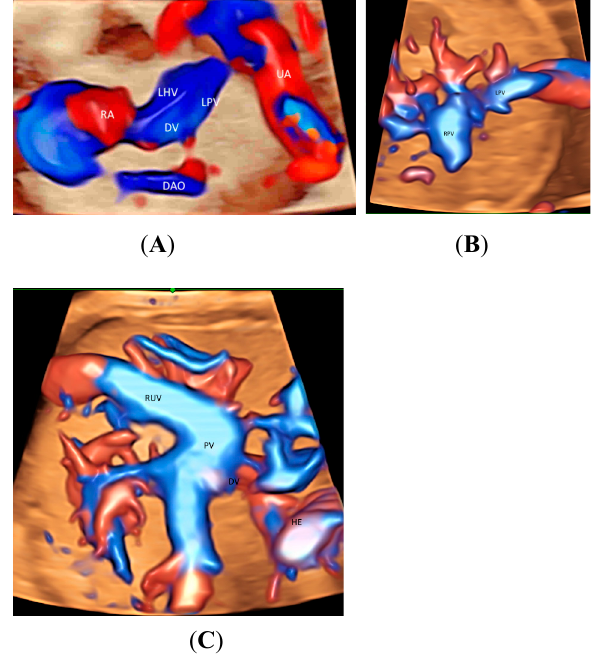
Figure 4. Spatiotemporal image correlation volume acquisition in color Doppler displayed in glass- body mode in a longitudinal view of a normal fetus at 14 weeks’ gestation ( A ), in a transverse view of a normal fetus at 21 weeks ( B ), and of a fetus with persistent right umbilical vein at 29 weeks ( C ). DAO, descending aorta; DV, ductus venosus; HE, heart; LHV, left hepatic vein; LPV, left portal vein; PV, portal vein; RA, right atrium; RPV, right portal vein; RUV, right umbilical vein; UA, umbilical artery.